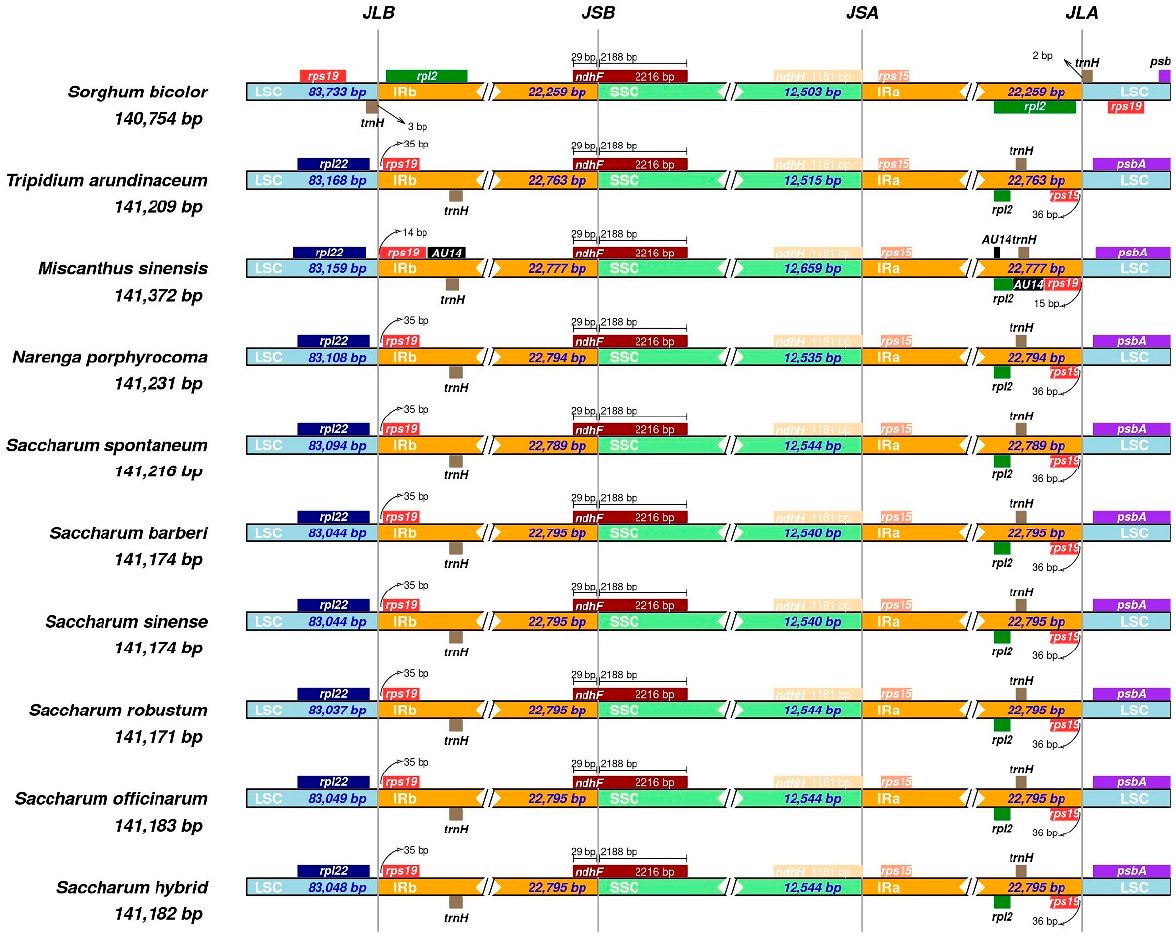
Figure 3. Comparison of border positions of LSC, SSC, and IR regions among nine Saccharinae species and S. bicolor . Genes are denoted by boxes, and the gap between the genes and the boundaries are indicated by the number of bases unless the gene coincides with the boundary. Extensions of genes are also indicated above the boxes.